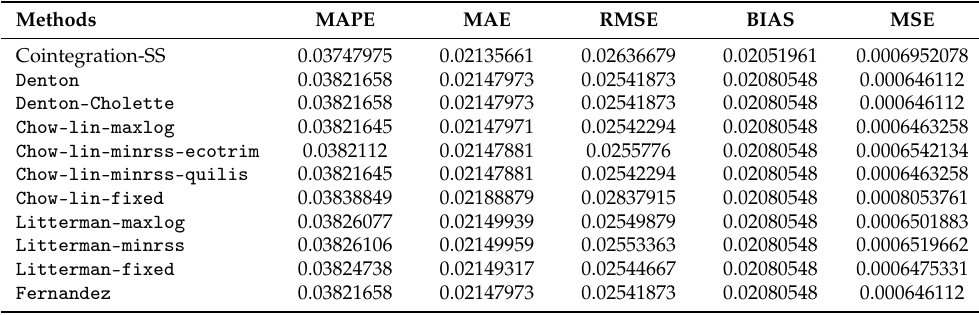
Table 6. Goodness of fit indexes for the quarterly series from 1986 onward for different disaggregation methods.